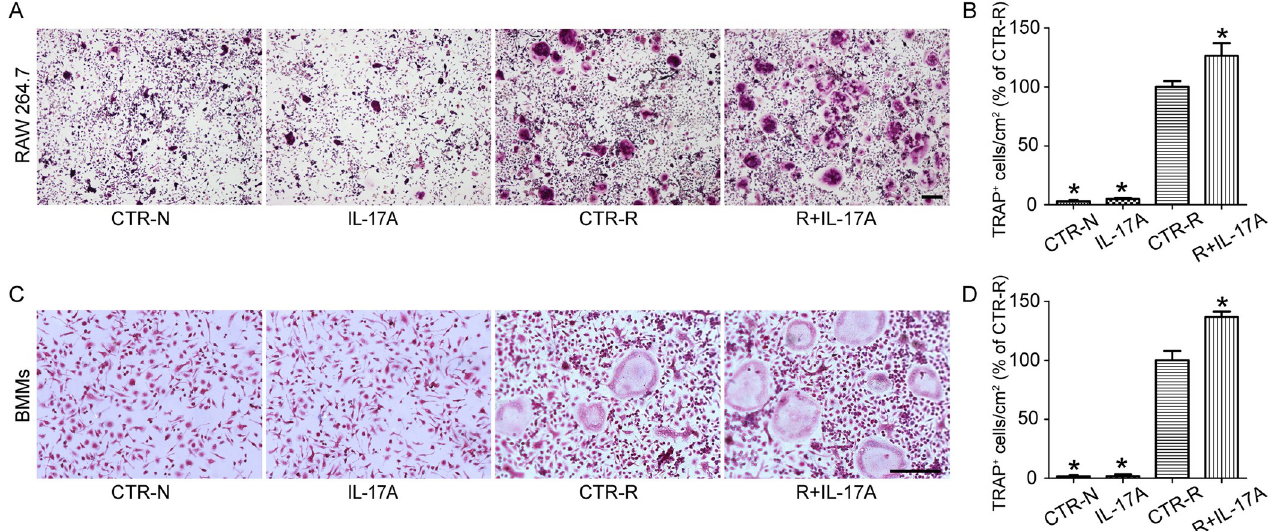
Fig 1. IL-17A promotes RANKL-stimulated osteoclastogenesis. (A) RAW 264.7 cells and (C) BMMs were cultured with or without IL-17A (1 ng/ml) in the presence of RANKL (50 ng/ml) for 5 d. (B, D) TRAP-positive multinucleated cells with three or more nuclei were considered as osteoclasts, and the number of osteoclasts were counted in each well. At least four wells were used for each tested reagent. Cells treated without RANKL and IL-17A (CTR-N) were used as a negative control. Cells not treated with IL-17A but exposed to RANKL (CTR-R) were used as a positive control. The values are expressed as the mean ± SD. � p < 0.05 compared with RANKL treatment. Scale bar, 200 μ